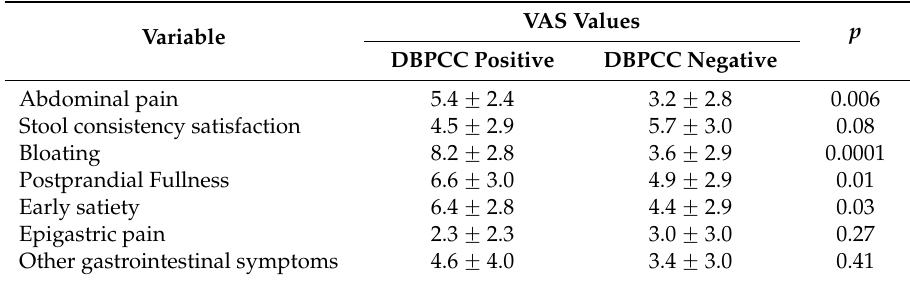
Table 4. Visual analogue scale (VAS) values of patients according to their positive/negative response to the gluten challenge.